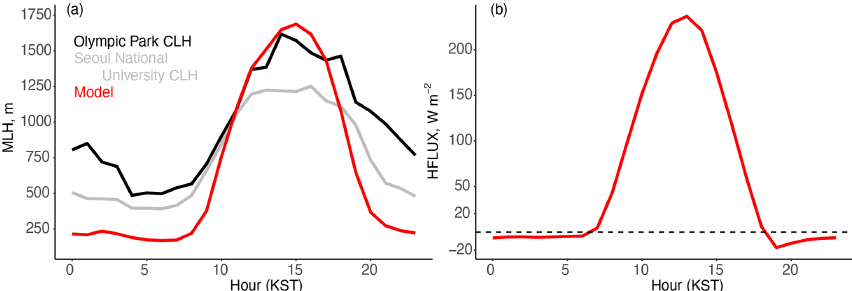
Figure 10. (a) Mean diurnal cycle for the mixed layer height (MLH) from the model and observations from 1 May to 7 June 2016, as well as (b) sensible heat flux (HFLUX) from the model. The MLH is given for the ceilometers (CLH) at Olympic Park (black) and at Seoul National University